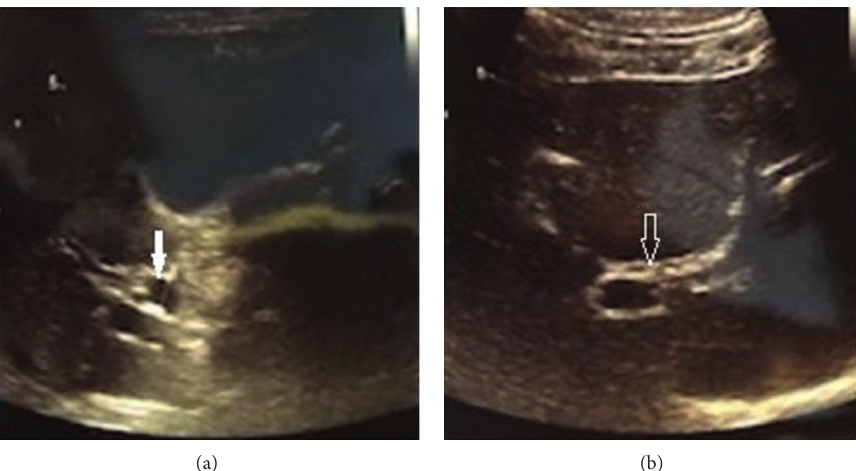
Figure 1: Abdominal ultrasound showing (a) dilated common bile duct (white arrow) (b) on the 12th hospital day normal appearance of common bile duct (arrow).